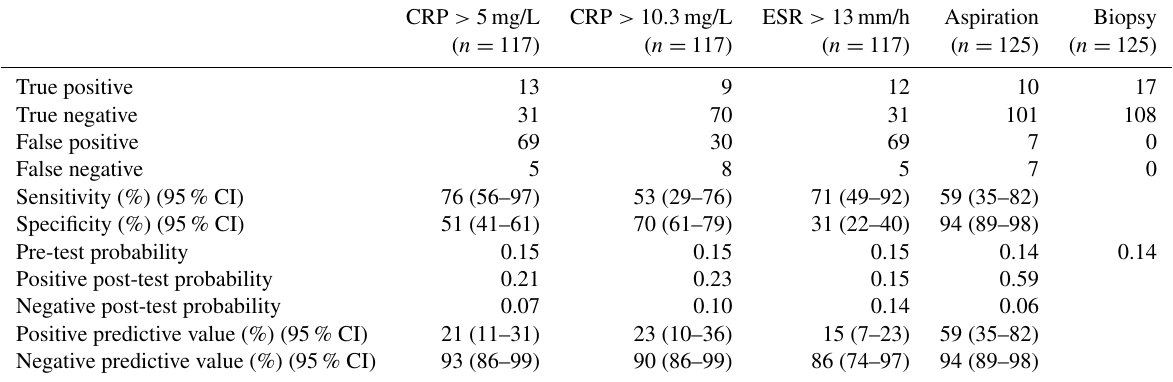
Table 1. Statistical analysis of CRP, ESR and aspiration; biopsy included for reference.